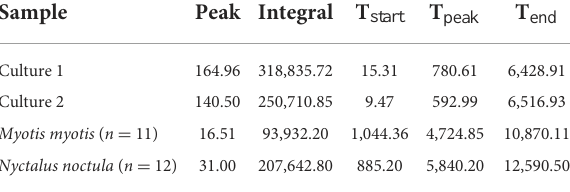
TABLE 6 Basic parameters of phagocyte respiratory burst measured in cell cultures (culture 1 and 2 correspond to average of 5 repetitions in 2 replicates) in this study and in whole blood of two bat species